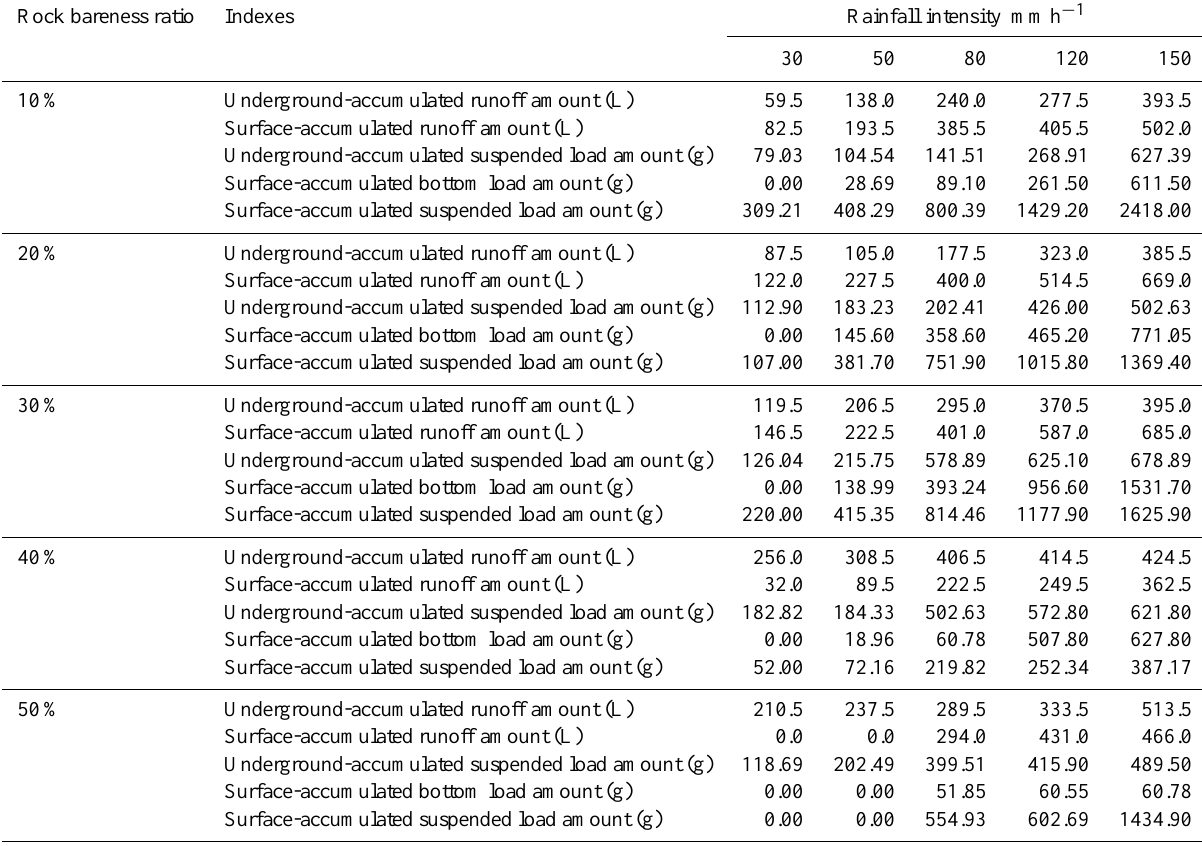
Table 8. Rates of exposed bedrock on the impact of runoff and sediment production. Rock bareness